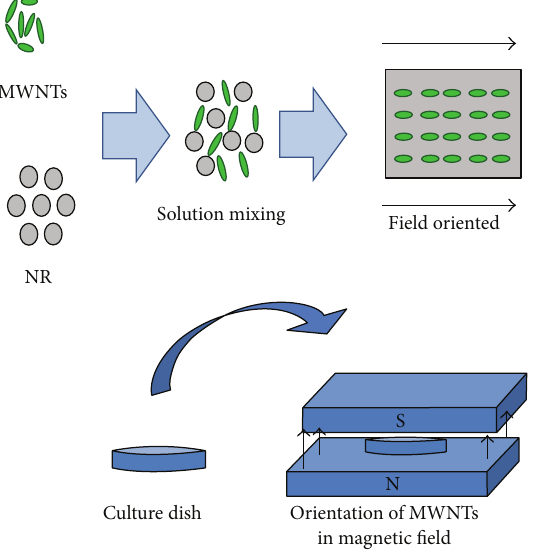
Figure 1: The orientation of MWNTs in NR in magnetic field.